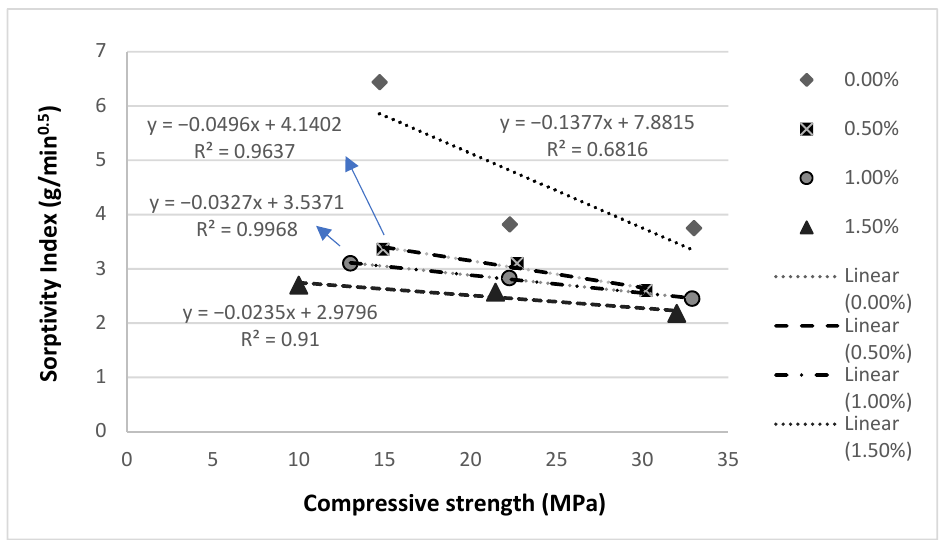
Figure 10. Correlation between compressive strength and sorptivity index at different curing ages.